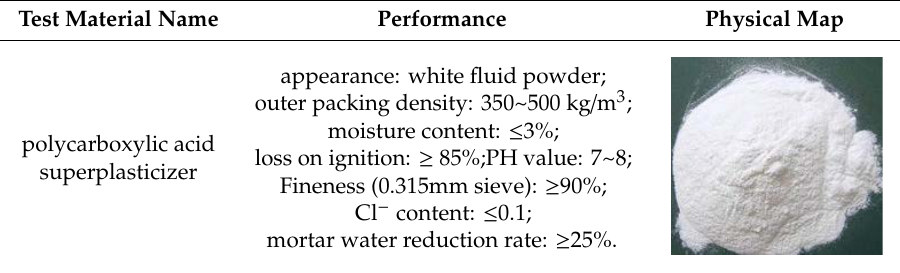
Table 5. Superplasticizer basic parameter table.